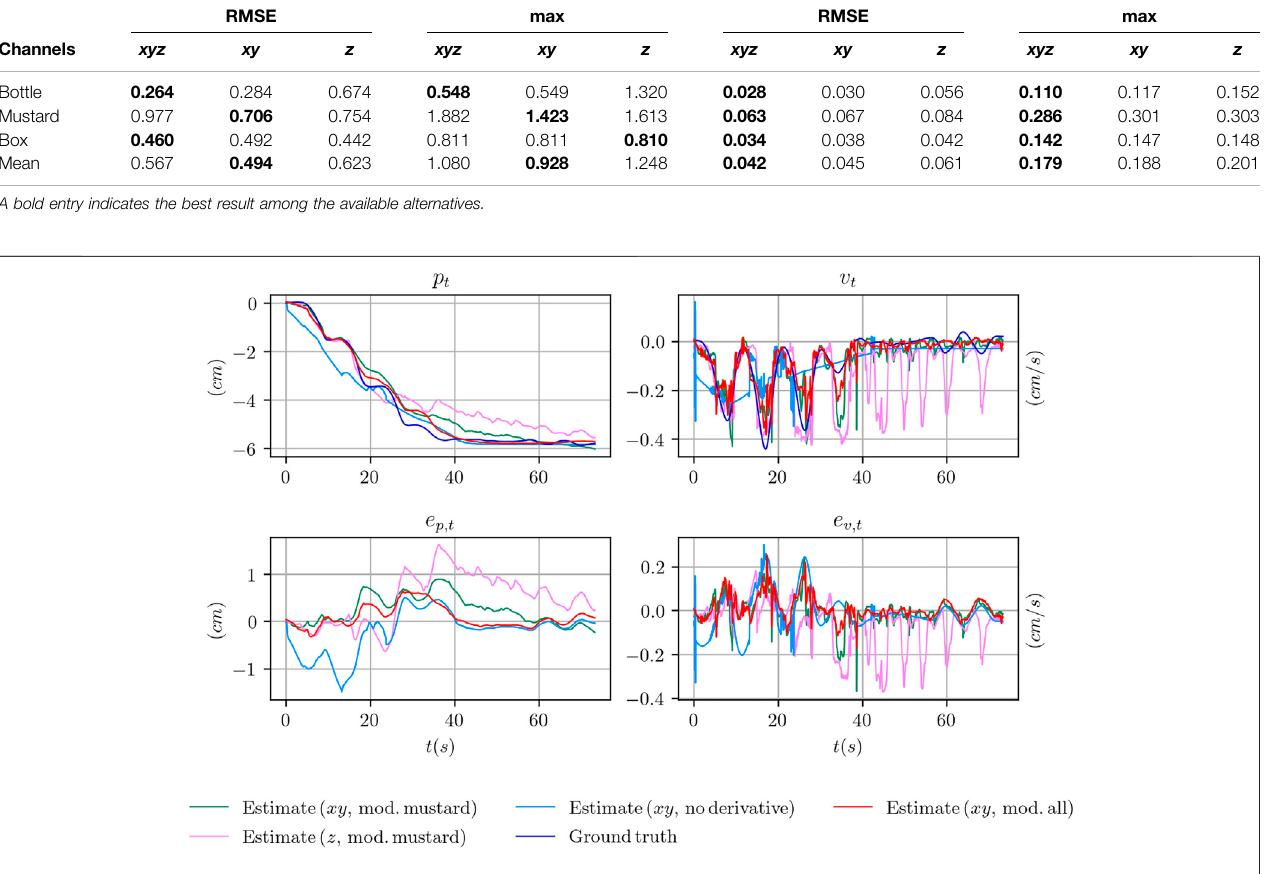
Frontiers in Robotics and AI |